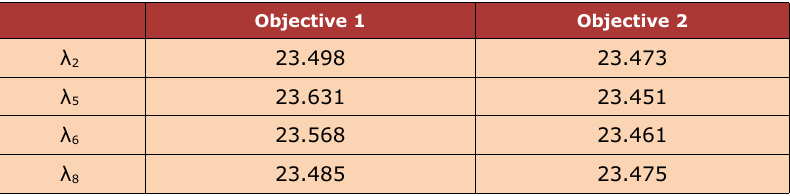
Table 11. Objective values for selected λ